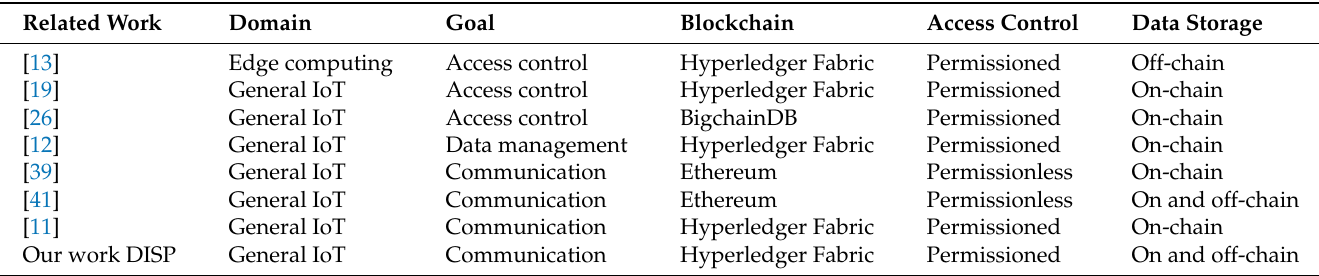
Table 1. Comparison of DISP to related